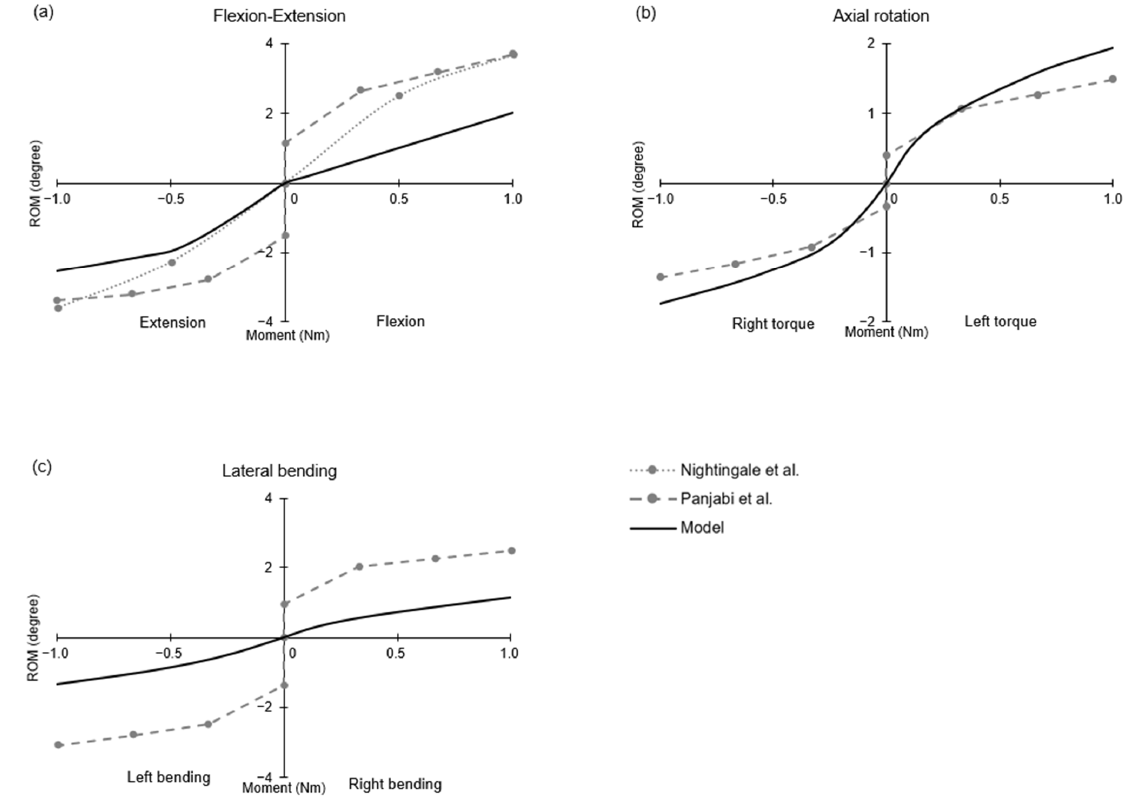
Figure 6. Comparison between the Moment–ROM curves of the FSU and the experimental data [34,35] during ( a ) flexion–extension, ( b ) axial rotation, and ( c ) lateral bending. during ( a ) flexion–extension, ( b ) axial rotation, and ( c ) lateral